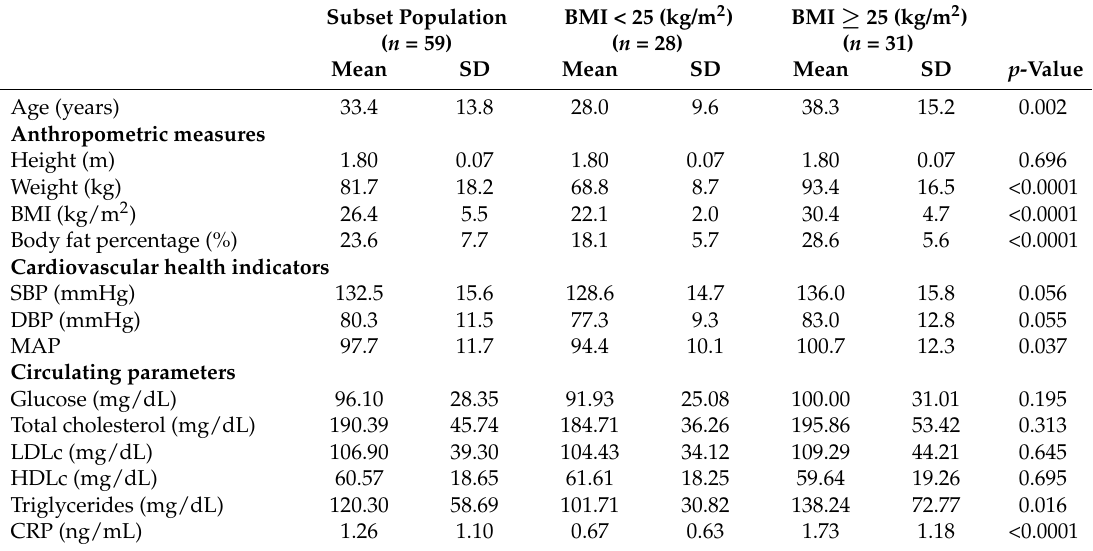
Table 3. Subjects characteristics 1